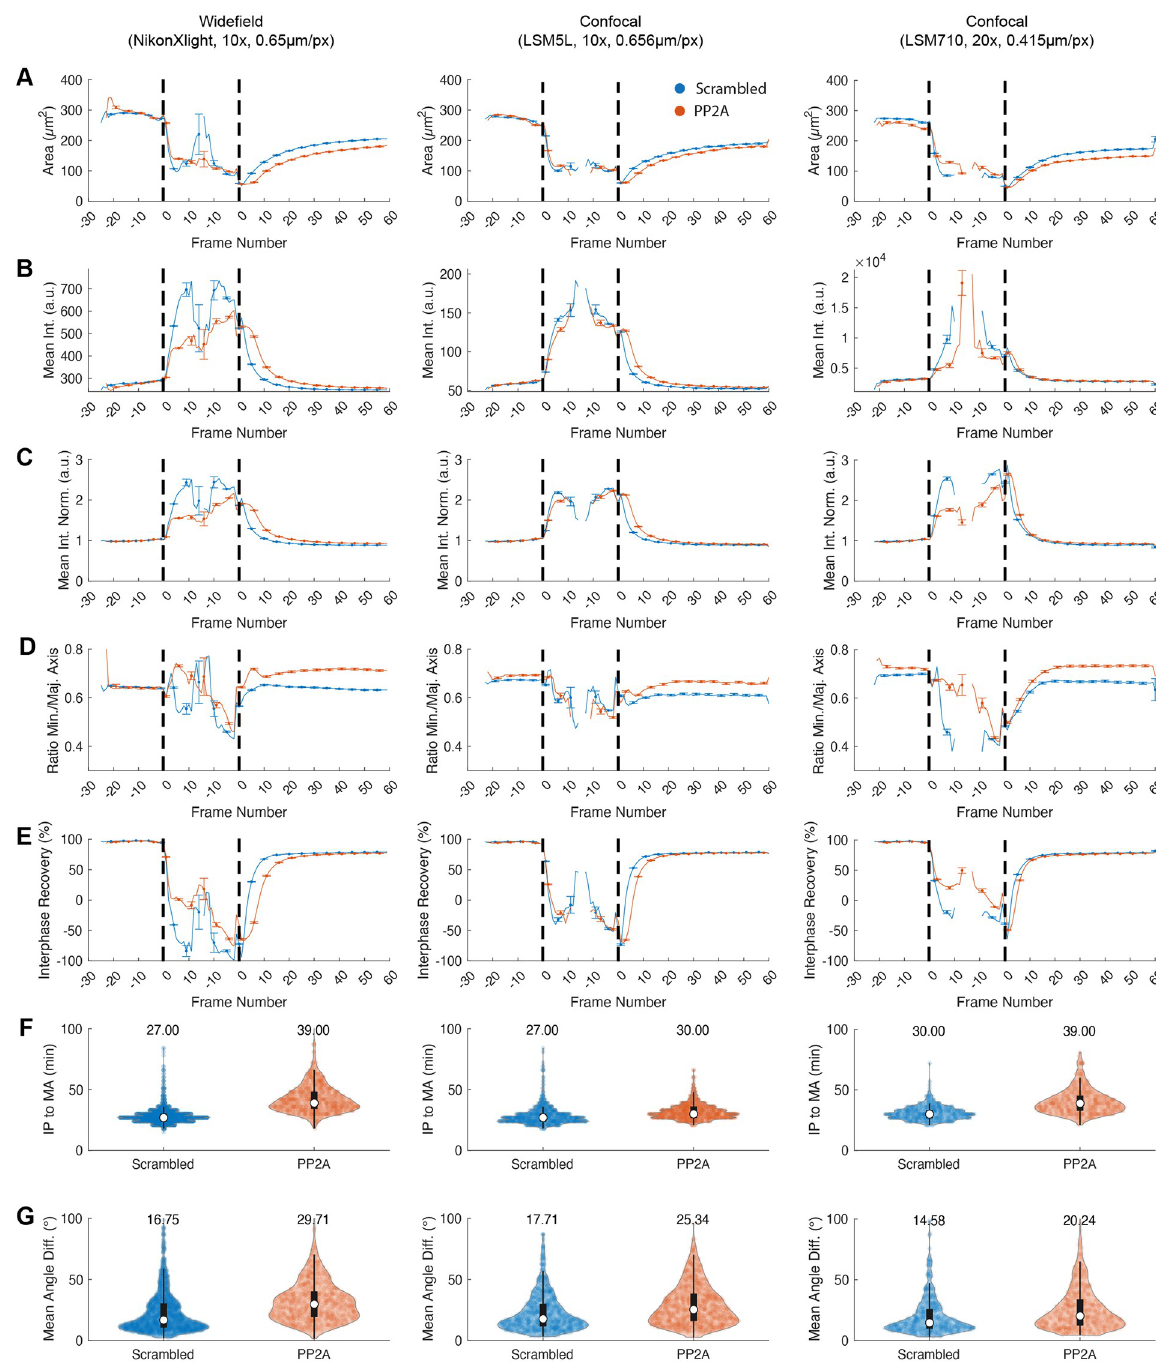
Fig 4. Platform comparison. Reproducibility study with different microscope systems. The columns show exemplary quantifications of the same experiment conducted on different microscopy platforms. We compare Scrambled (control, blue) vs. PP2A knockdown cells (orange). The time series features involve the chromatin area ( μm 2 ) (A), the chromatin mean intensity (a.u.) (B), the normalized mean intensity (absolute intensity values divided by the interphase mean intensity of each cell, a.u.) (C), the minor axis vs. major axis ratio (D) and interphase-recovery feature as detailed in S2 Table (E). The violin plots show the duration between interphase-prophase and meta-anaphase transition in minutes (F) and the sum of the absolute angular changes in degrees (G). Widefield 10 × : N Scrambled = 1262, N PP2A = 1198; Confocal 10 × : N Scrambled = 2830, N PP2A = 1008; Confocal 20 × : N Scrambled = 792, N PP2A = 668.